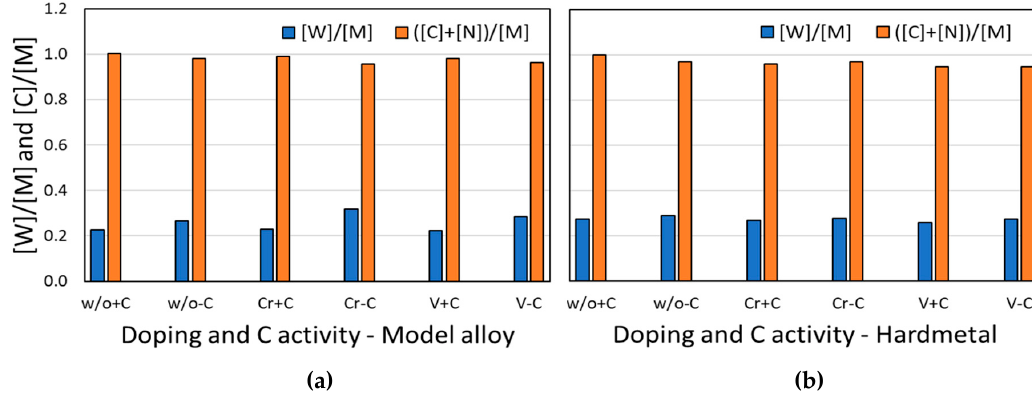
Figure 3. The composition of the MC/M(C,N) phase. Tungsten mol fraction ([W]/[M] of the metal lattice, and ([C]+[N])/[M] (with and without Cr or V) in the formula (Ti,Ta,Nb,W{Cr,V})(C,N) as a function of doping (without: w/o, Cr and V doping). ( a ) in hardmetals at low ( − C) and high (+C) C activity, ( b ) in model alloys with eta phase ( − C) and free carbon (+C).